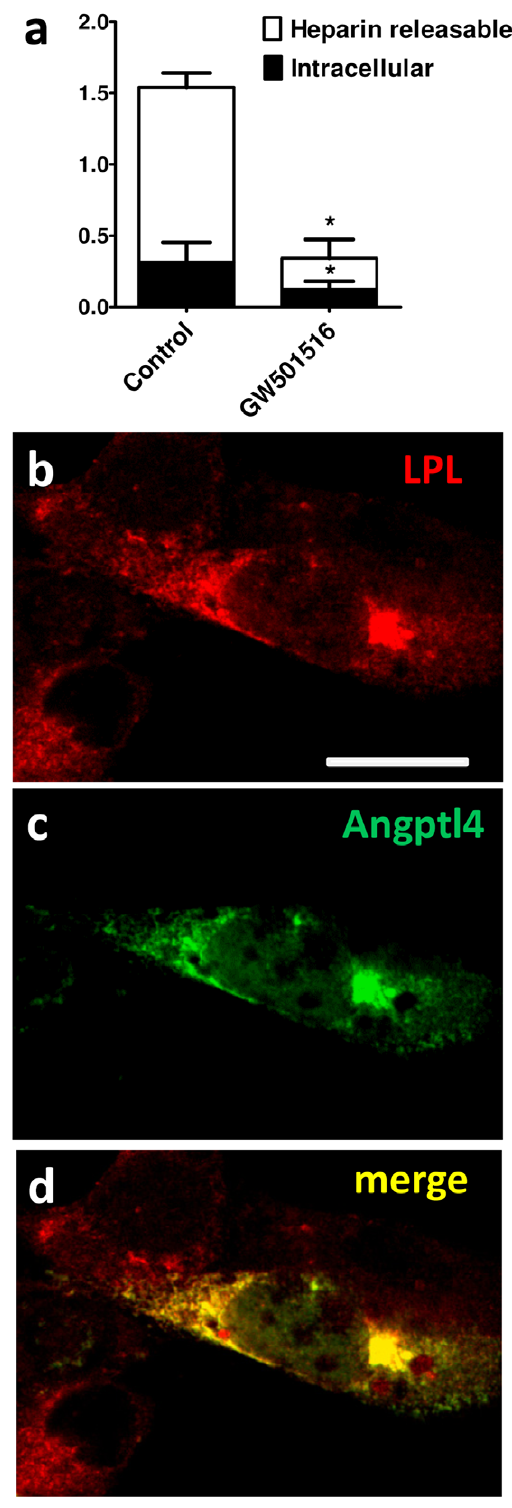
Figure 7. Angptl4 inhibits intracellular LPL activity and co- localizes with intracellular LPL. ( a ) Heparin releasable and intracellular LPL activity was measured in C2/LPL myotubes incubated with GW501516 (0.1 m M) for 24 hours, n=3. ( b, c, d ) Confocal microscopy of myoblasts transfected with V5 tagged Angptl4 and stained with antibodies against LPL ( b ) and V5 tag ( c ). Scale bar: 20 m m. * p , 0.05, paired t test.